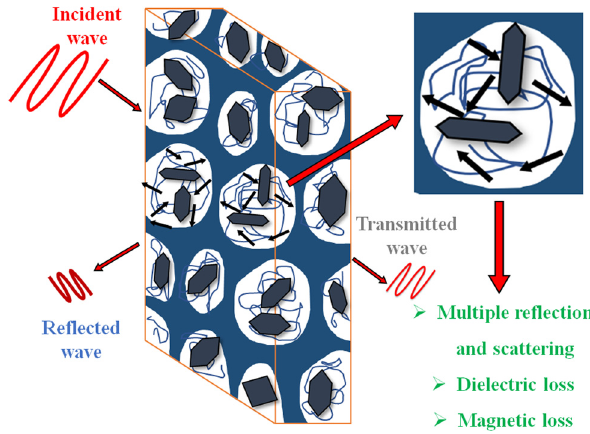
Figure 8: EMI shielding mechanism of Ni/GO/PVA